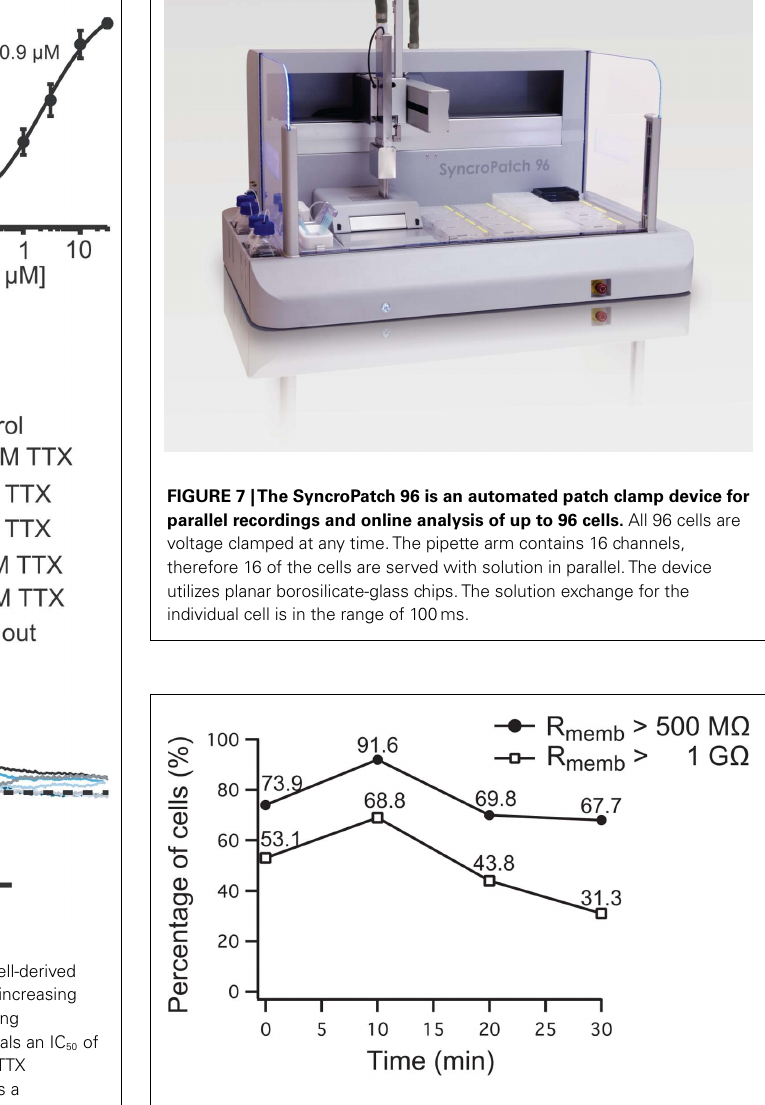
the heated solution was applied to the cell at a speed of 10 μ l/s.